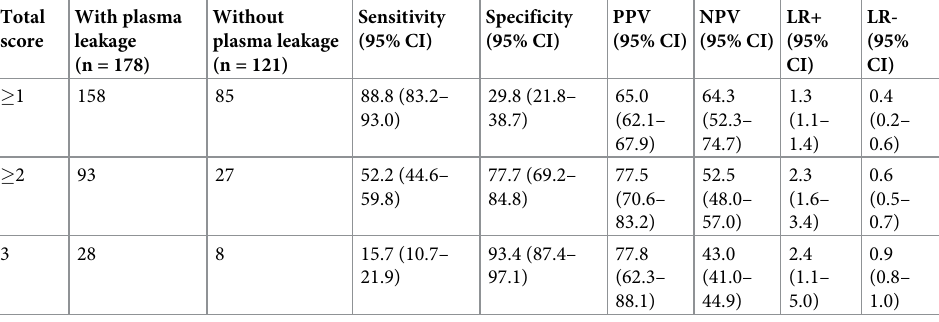
Table 8. Prognostic values of the plasma-leak score for predicting plasma leakage. Total With plasma score